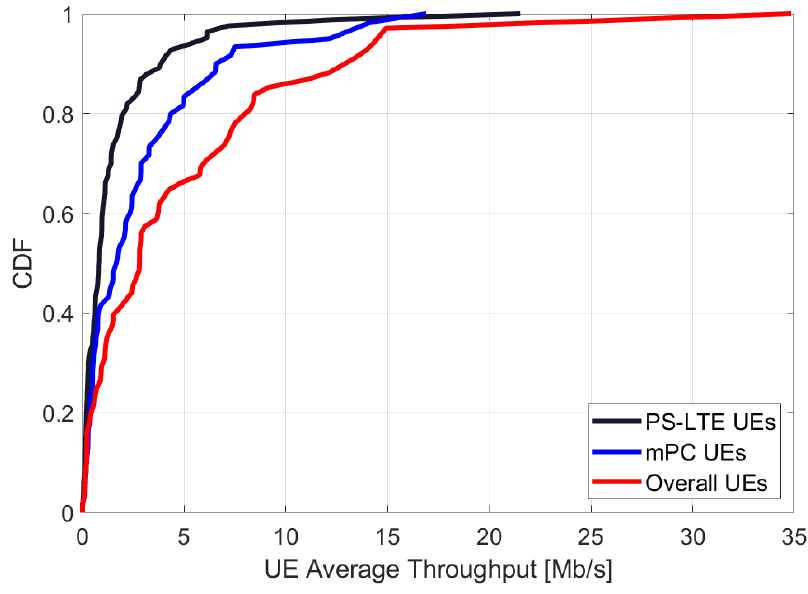
Figure 5. UE Rx interference.